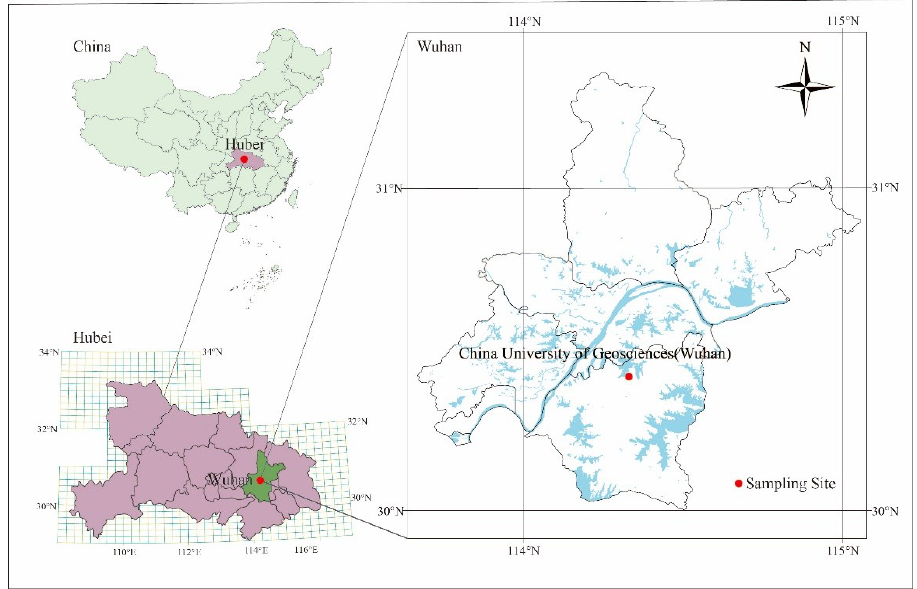
Figure 2. The location map of sampling site.